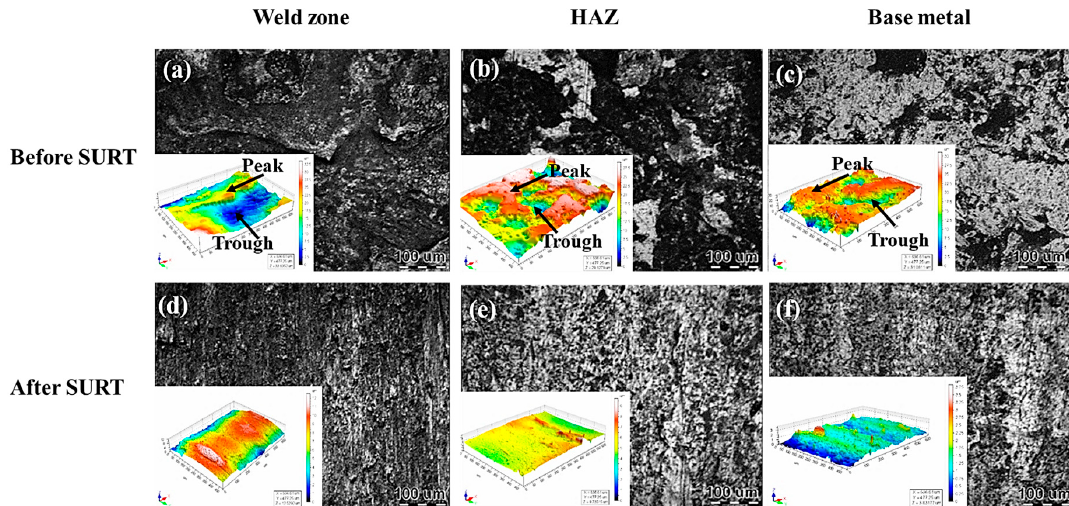
Figure 3. Surface morphology of T4003 ferritic stainless steel welded joint before and after SURT. ( a – c ) Surface morphology before surface ultrasonic rolling treatment (SURT). ( d – f ) Surface morphology after SURT. ( a , d ) Weld zone. ( b , e ) Heat affect zone (HAZ). ( c , f ) Base metal.